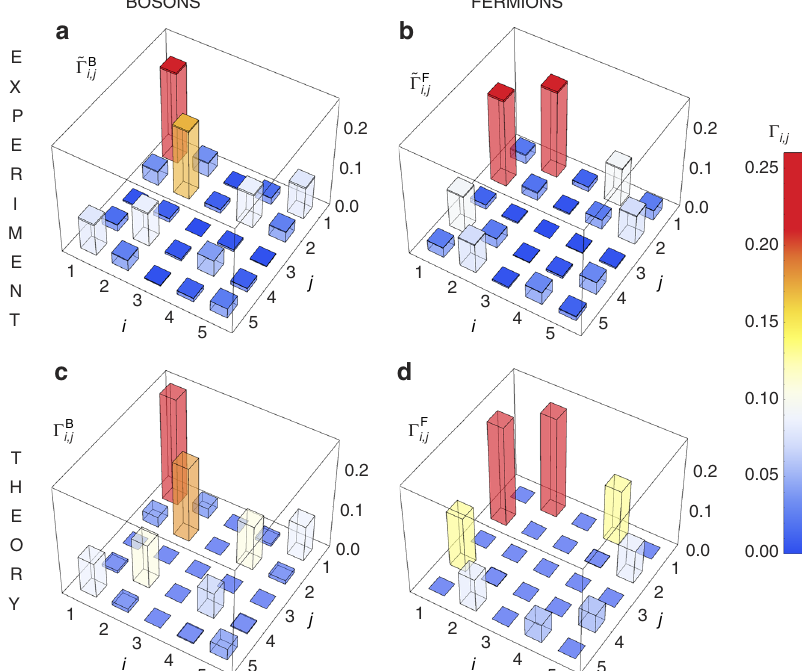
Fig. 3 Correlation measurements with the quantum transport chip. a , b Experimental results of the correlation function, ~ Γ ij , for bosonic and fermionic transport. Darker parts on top of the bars represent 1 σ errors for the experimental data, and are due to the poissonian statistics of the coincidence counts. c , d Theoretical prediction for the correlation function, for bosonic and fermionic transport obtained from the unitary matrix U of the transport device. Typical coincidence rates were ~55 per second for all output con fi gurations combined